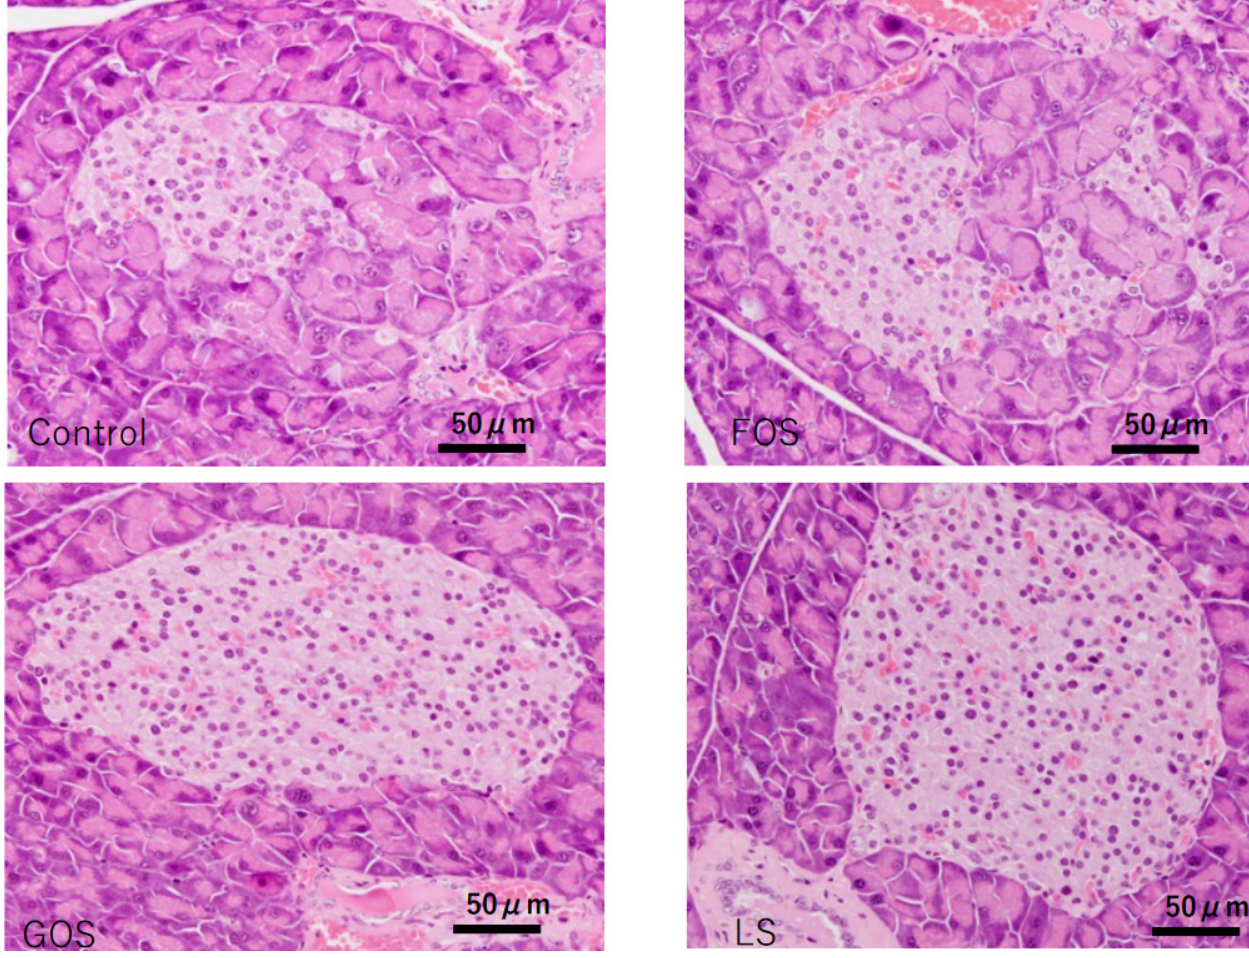
Figure 8. Characteristic pathological features of the islets of Langerhans in the pancreas of each group in experiment 2. In the control and FOS groups, most of the islets showed swelling and degeneration, while there were no destructive changes observed in most of the islets in GPS and LS groups (HE staining, scale bar: 50 m). Table 5. Histopathologic evaluation of the damage of islets of Langerhans in experiment